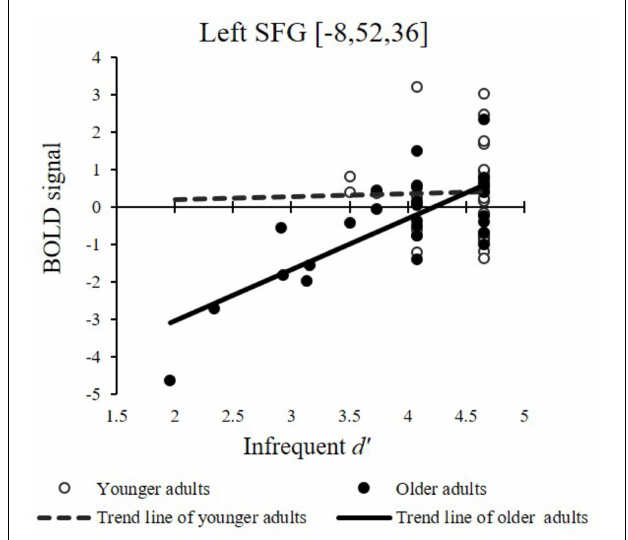
FIGURE 4 | Associations between individual infrequent d’ scores in the infrequent idiom vs. random condition and brain contrast responses in younger and older adults in the left Superior Frontal Gyrus showed significant whole-brain age difference in the neural-behavior